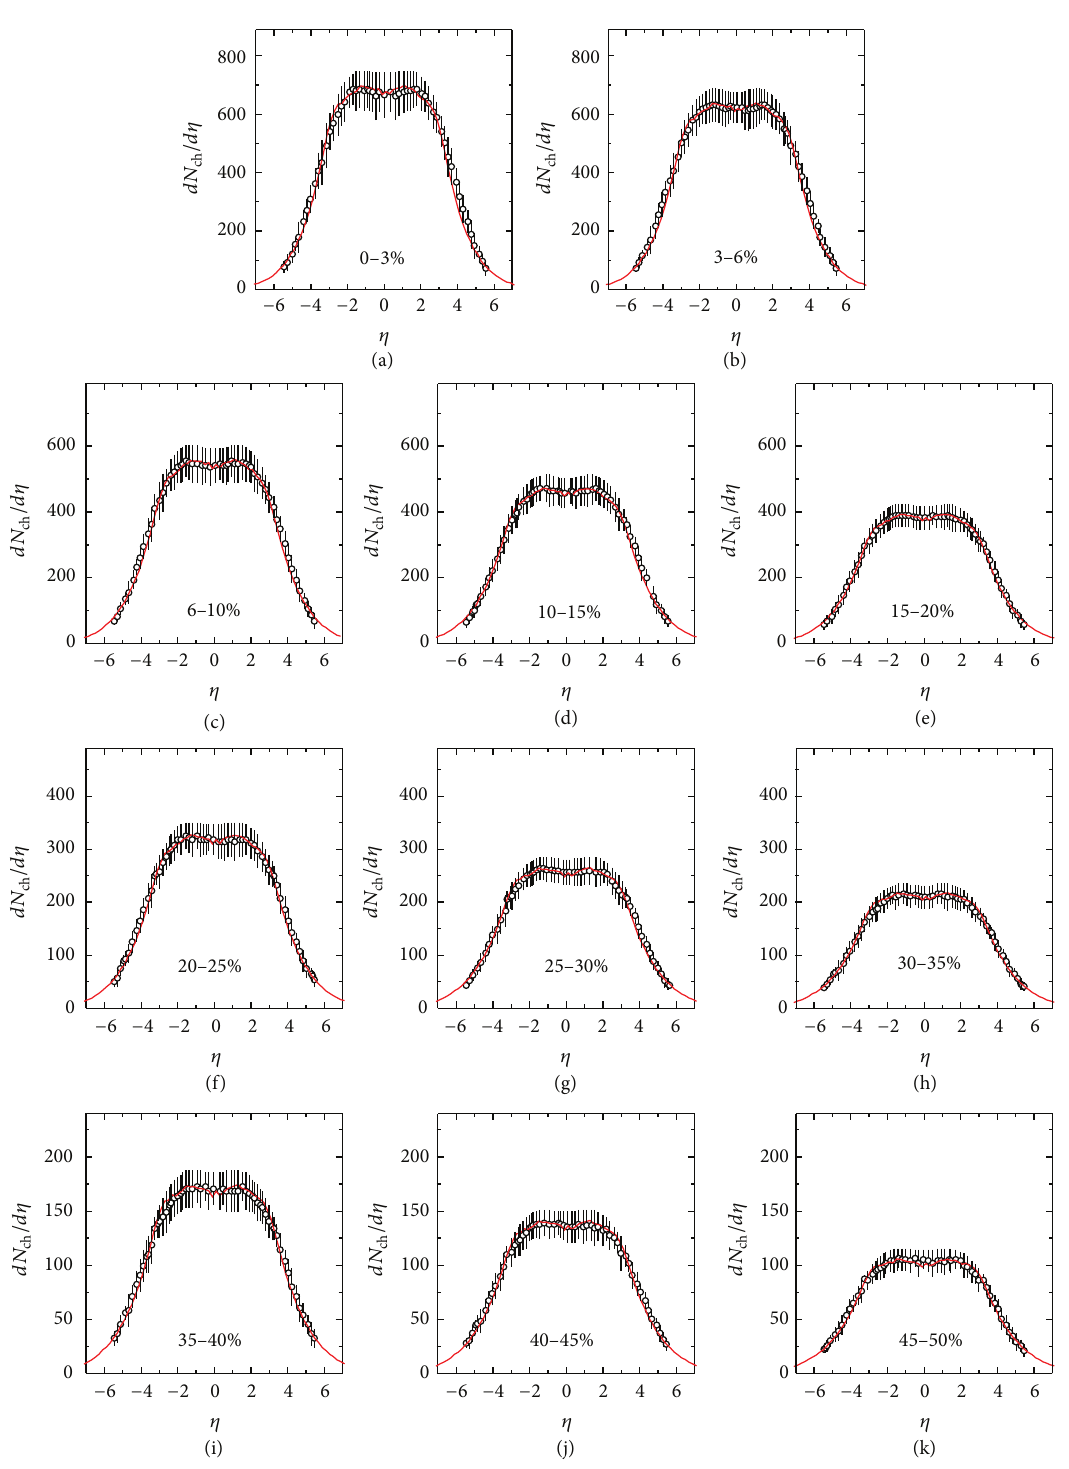
Figure 4: The same as Figure 1 but showing the results of Au-Au collisions at √ 𝑠 NN = 200